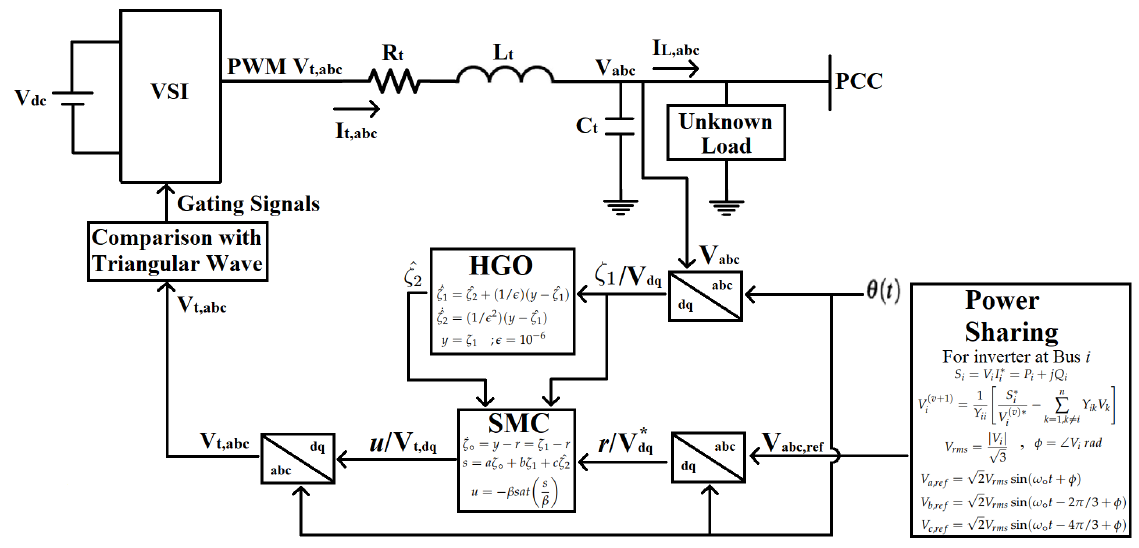
Figure 2. SMC with an HGO-based control scheme applied for the VSI voltage